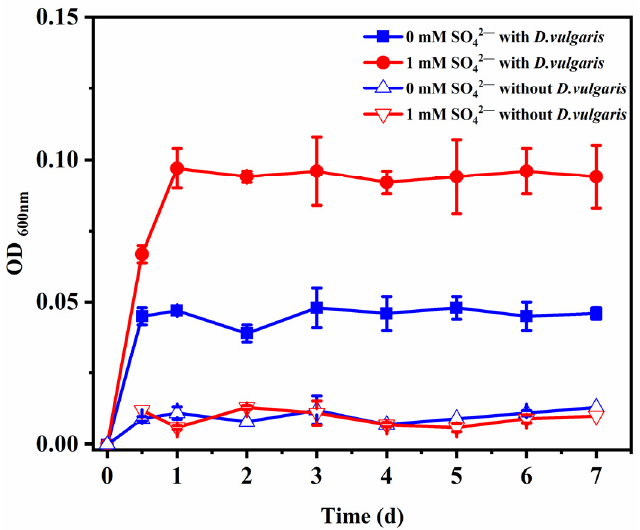
Figure 3. Variation of OD 600nm in As(V) reduction experiment. Error bars indicate standard deviation of triplicates.